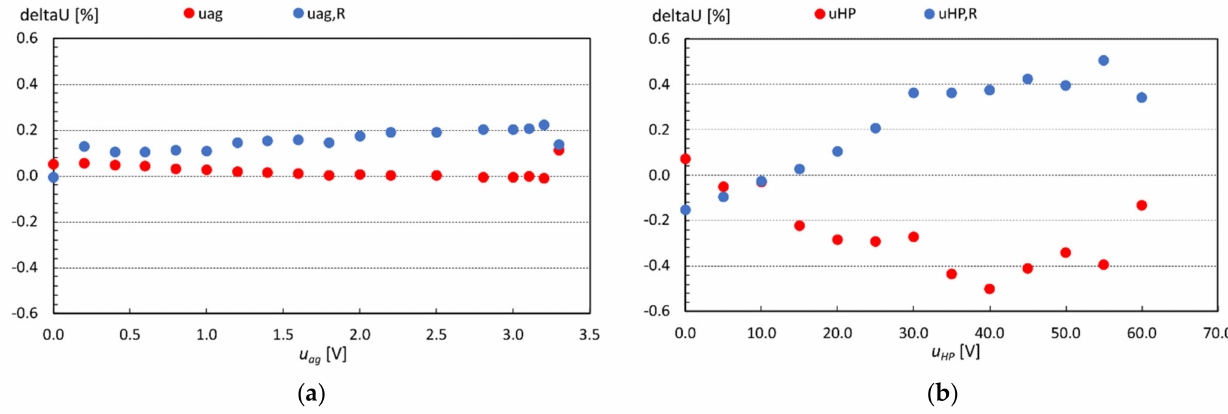
Figure 16. Voltage error for original and reversed polarity of measured voltage on the nominal range: ( a ) for u ag ; ( b ) for u HP